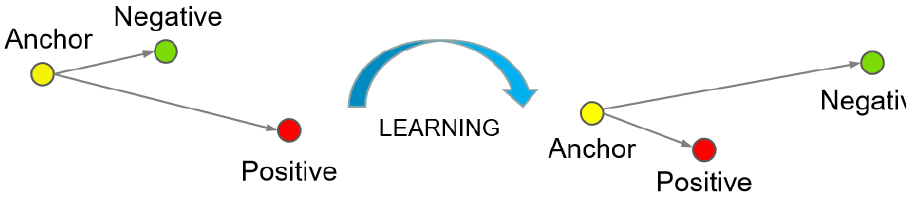
Figure 2. The Triplet Loss minimizes the distance between an anchor and a positive, both of which have the same identity, and maximizes the distance between the anchor and a negative of a differ- ent